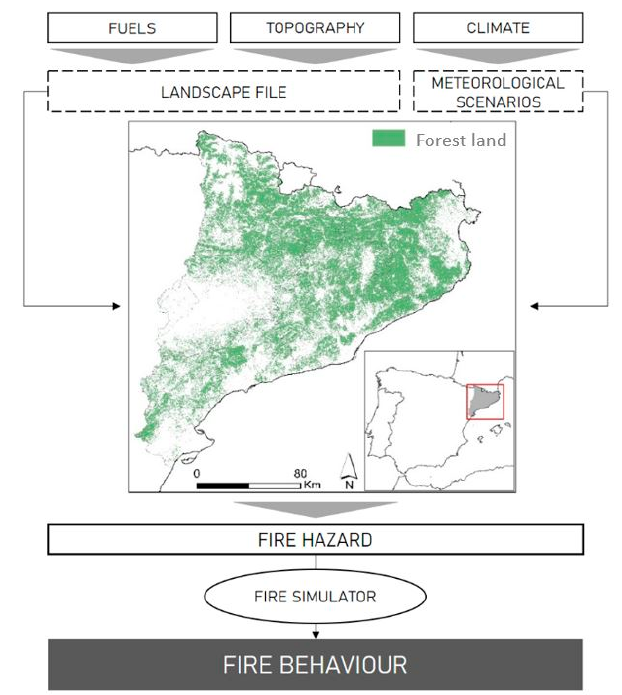
Figure 1. Schematic diagram of the conceptual design of the